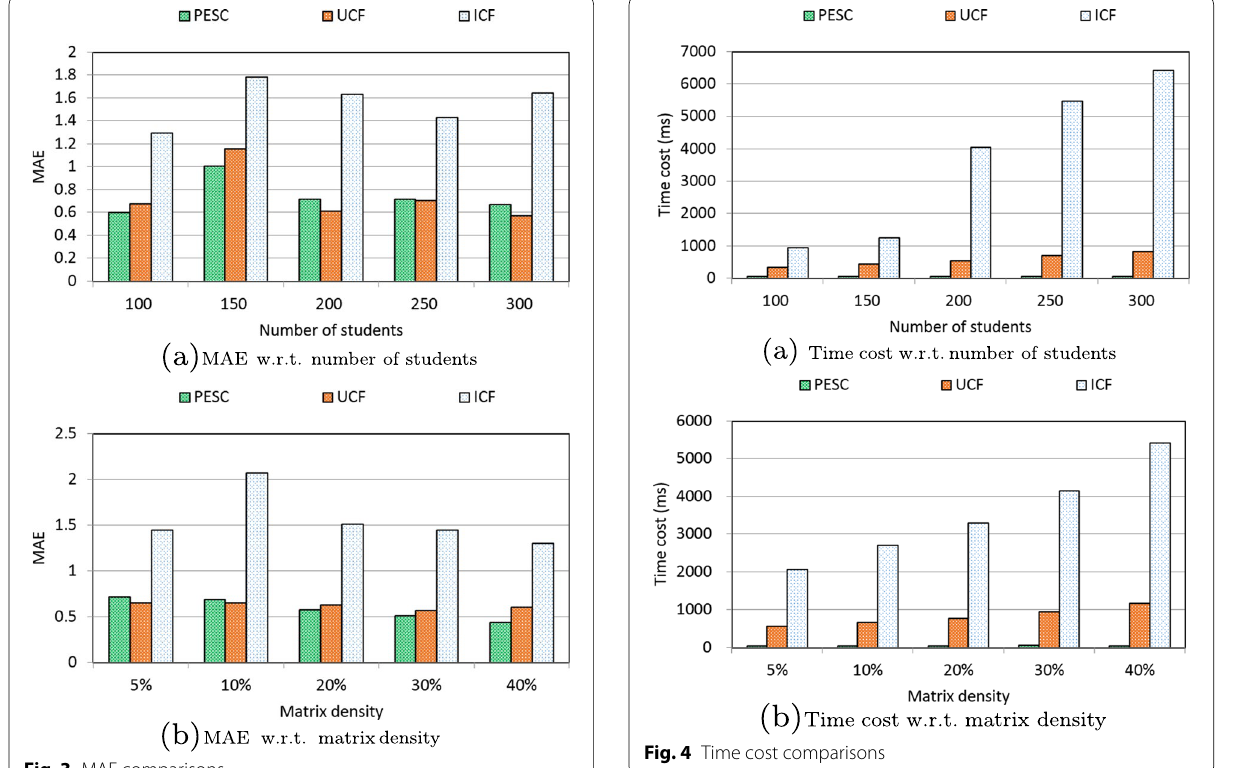
Fig. 3 MAE comparisons